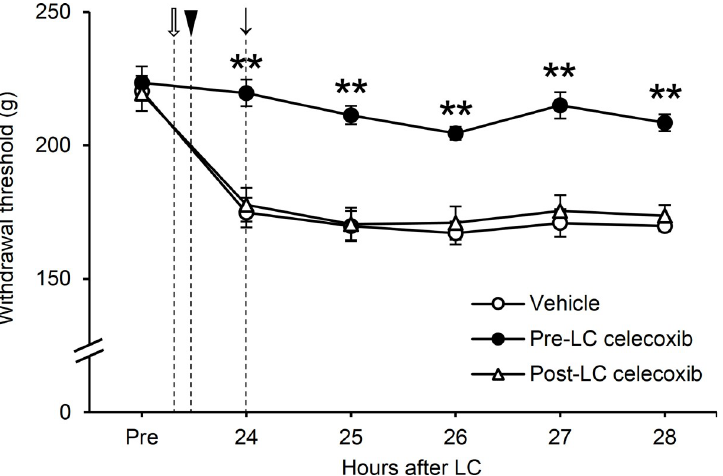
Fig 2. Effects of celecoxib on the development and maintenance processes of lengthening contractions (LC)- induced muscular mechanical hyperalgesia. Celecoxib (10 mg/kg, p.o.) was administered either 1 h before (Pre-LC celecoxib, white arrow) or 24 h after LC (Post-LC celecoxib, black arrow). Baseline withdrawal thresholds (Pre) were measured 1 day before LC. An arrowhead indicates the time point of LC. The development of mechanical hyperalgesia was blocked when celecoxib was administered 1 h before LC in the Pre-LC celecoxib group, but not when administered 24 h after LC in the Post-LC celecoxib group (n = 6 rats in each group, �� P < 0.01 vs. vehicle and Post- LC celecoxib, two-way repeated measures ANOVA followed by Tukey’s post-hoc test).